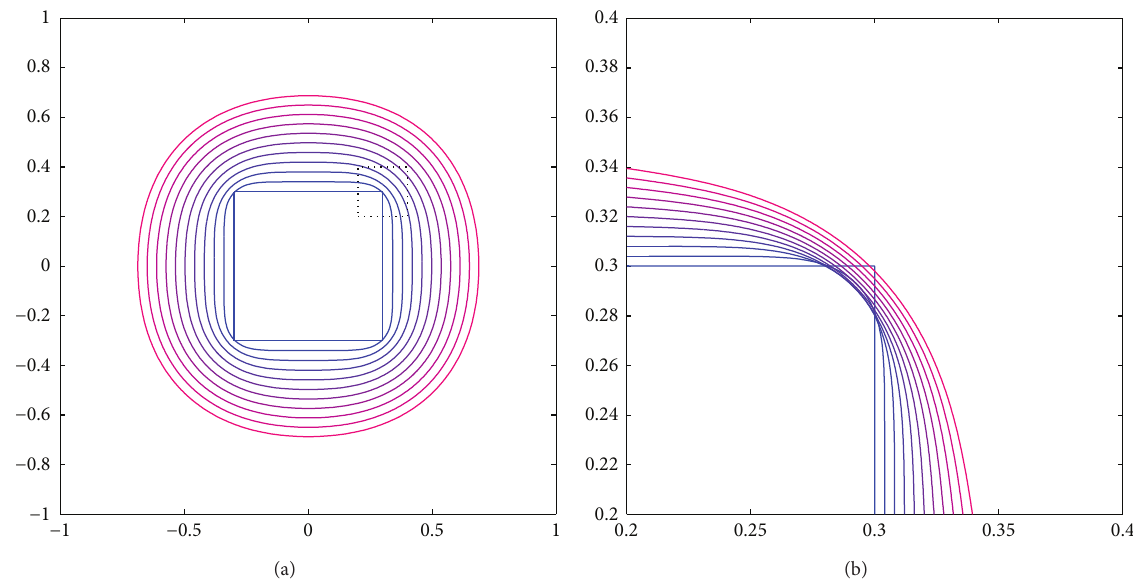
Figure 1: (a) The front evolution starting from a rectangular initial front is illustrated. The initial front is a square centered at the origin whose length of a side is 0.6. The front evolution speed is 𝑆 0 (1 − D 𝜅) with 𝑆 0 = 0.04 and D = 0.05 . The sequence of fronts is plotted from 𝑡 = 0 to 𝑡 = 10 with Δ𝑡 = 1 . (b) This figure shows an enlargement of the motion of the front near the corner marked as a dotted box on (a). This is the motion of the front from 𝑡 = 0 to 𝑡 = 1 with Δ𝑡 = 0.1